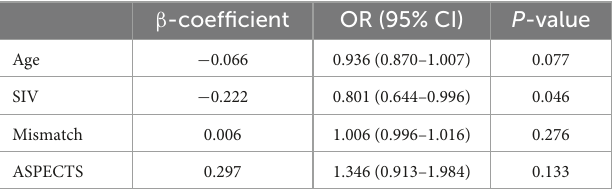
TABLE 2 Multivariable logistic regression analysis for predictors of outcomes at 90